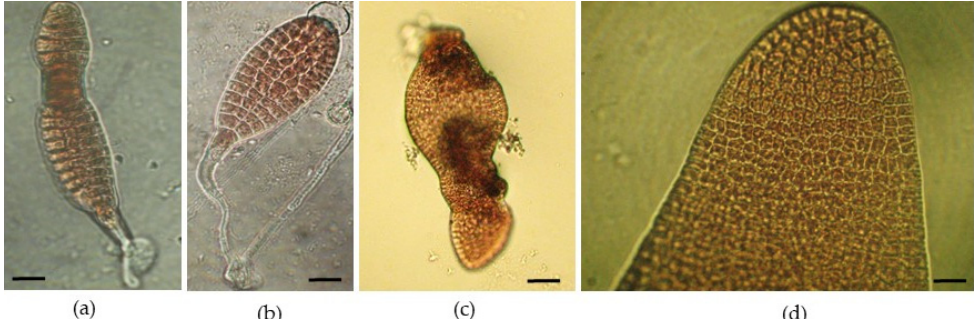
Figure 2. ( a ) Cell division of young blade (scale bar: 50 μ m); ( b , c ) proliferation of young foliose thalli with long rhizoids (scale bar: 50 μ m); ( d ) details of the apical part of young thallus (scale bar: 20 μ m).